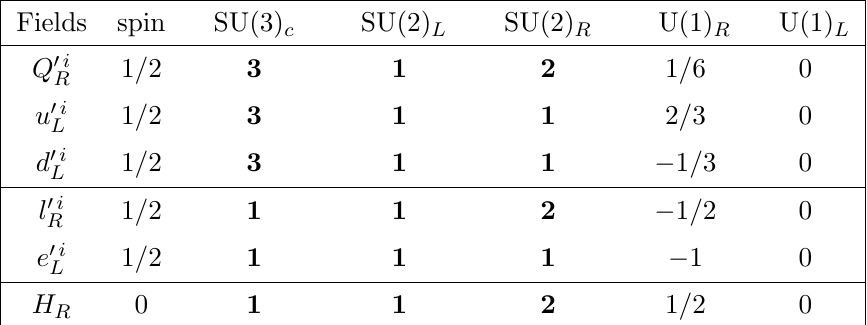
Table 2 . Matter content in the mirror sector. i denotes the (cid:13)avors: i = 1 ; 2 ;